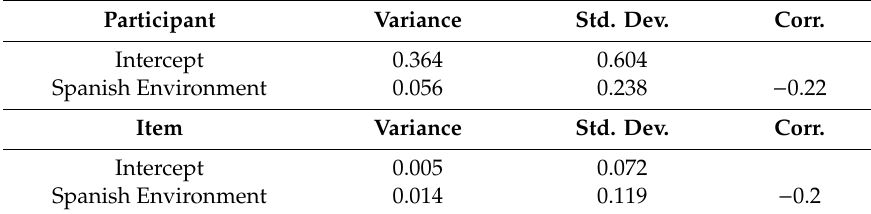
Table A4. Global Accent Rating Model with Proficiency Random E ff ects.